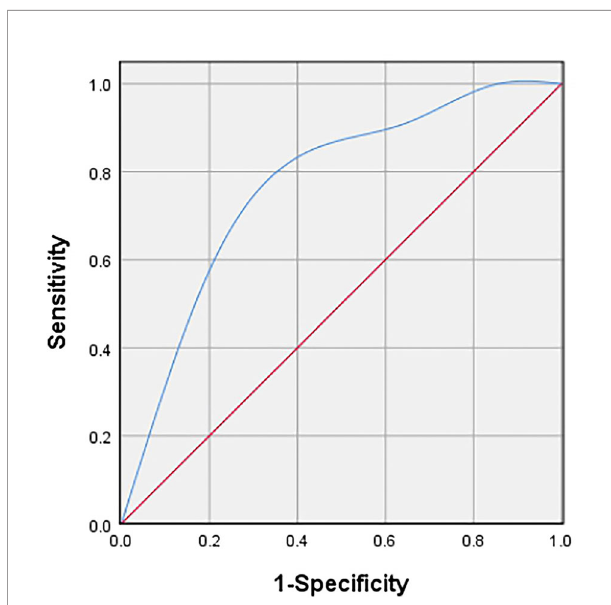
FIGURE 4 | Receiver operating characteristic (ROC) curve to determine the cut-off value of the vascular density grade with Adler criteria in discriminating between high and low proliferation groups.